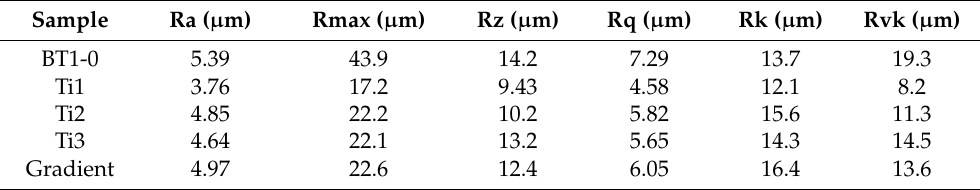
Table 4. Roughness values of coatings.